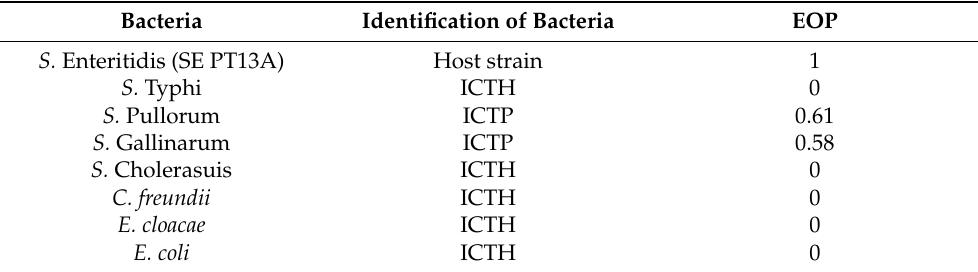
Table 3. Efficiency of Plating (EOP) of phage S1. Bacteria Identification of